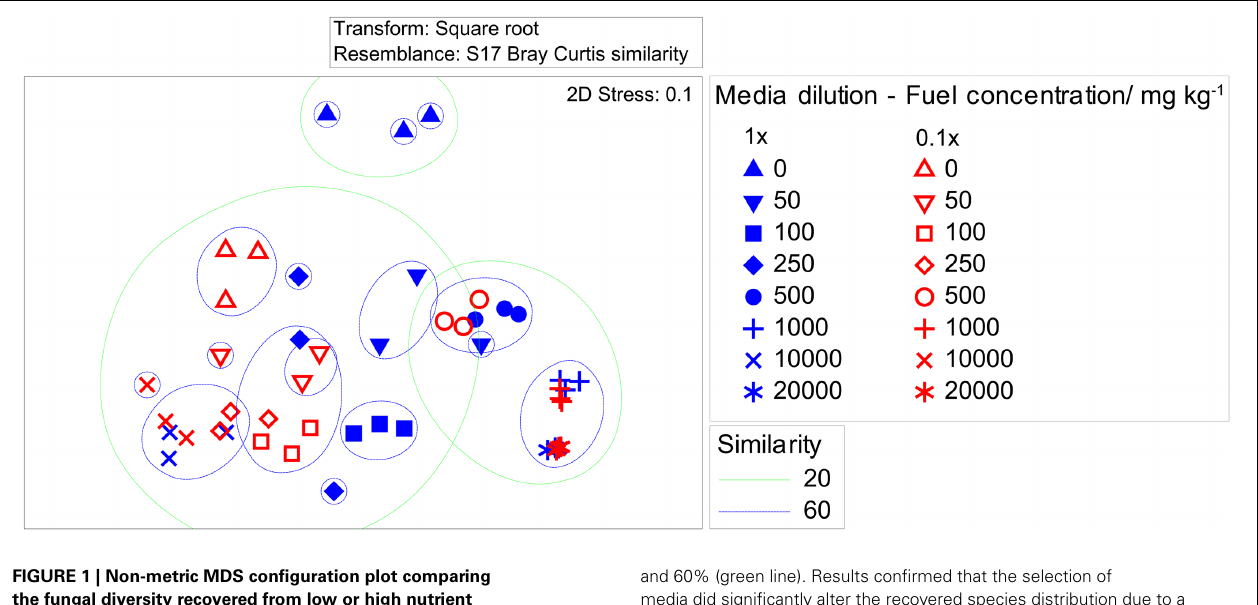
FIGURE 1 | Non-metric MDS configuration plot comparing the fungal diversity recovered from low or high nutrient media. Non-metric multi-dimensional scaling (NMDS) plot of similarities calculated using the bray–curtis coefficient using square root transformed fungal diversity data.The NMDS plot includes superimposed clusters at similarity levels of 20% (blue line)